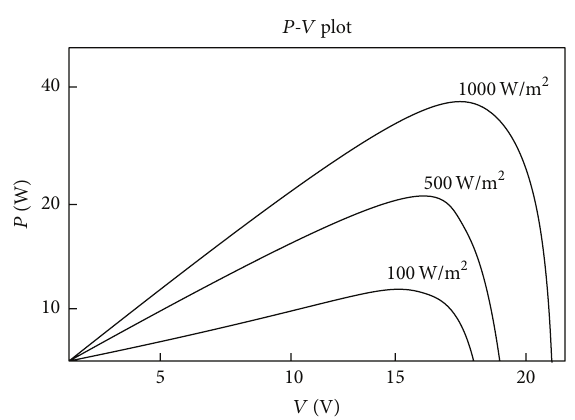
Figure 5: Characteristics curve for SOLKAR 36 W module . 𝑃 - 𝑉 curves of SOLKAR 36W at different radiations.